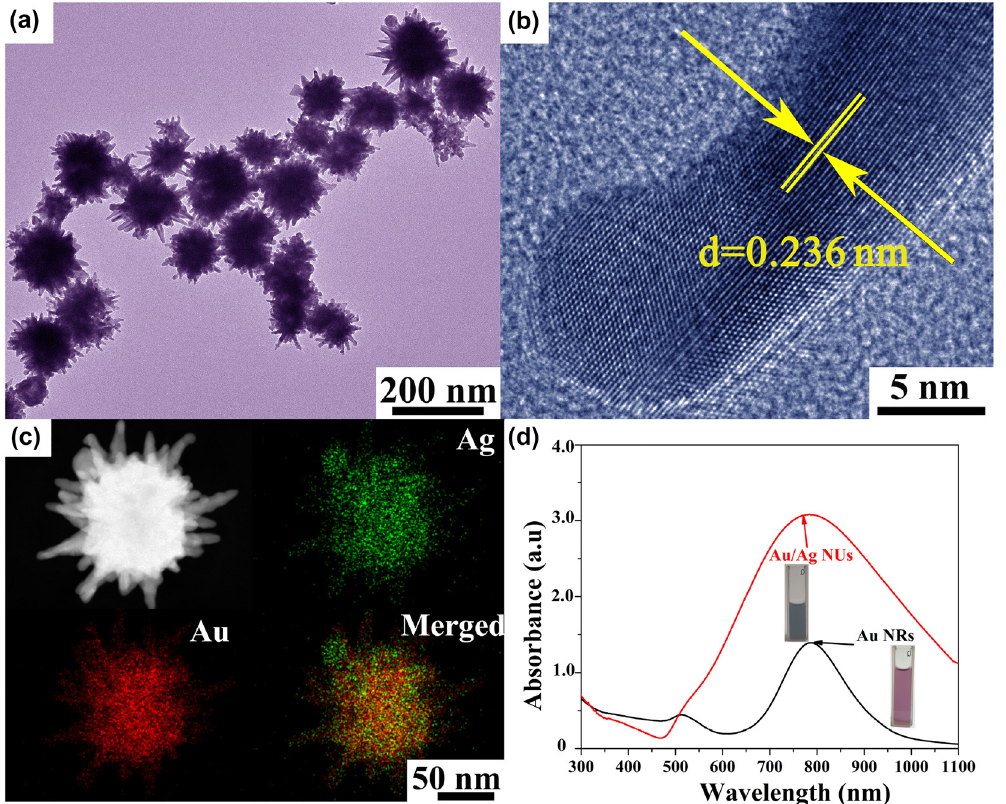
Figure 2: The microstructure of nanoproducts. (a) The TEM image and (b) representative HRTEM image of Au/Ag NUs. (c) The typical enlarged TEM image and the element mapping images of an individual Au/Ag NU. (d) The absorption spectra of colloidal Au/Ag NUs and Au NRs with the concentration of 0.01 mg/mL in each